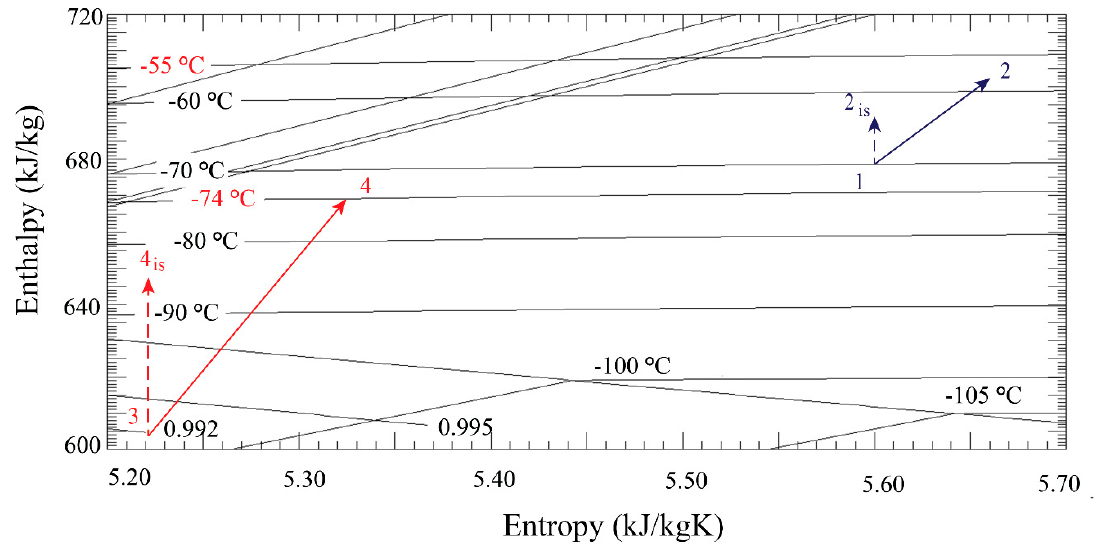
Figure 3. Low-duty turbo compressor, two running points, the lowest measured load (1-2), and the highest measured load (3-4).